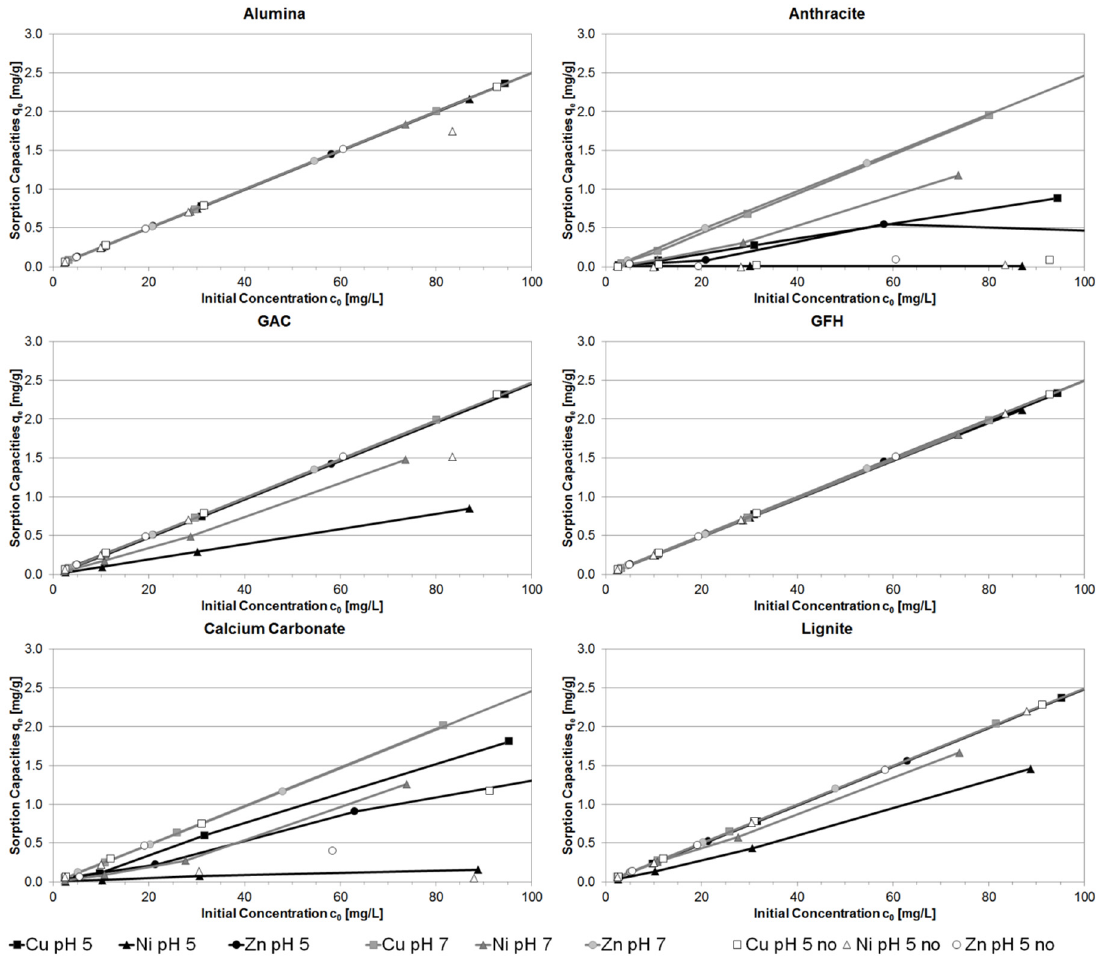
Figure 2. Influences of a buffer at pH 5 and pH 7 for the rotary shaker. For comparison, pH 5 without a buffer (metal pH 5 no) is also presented.